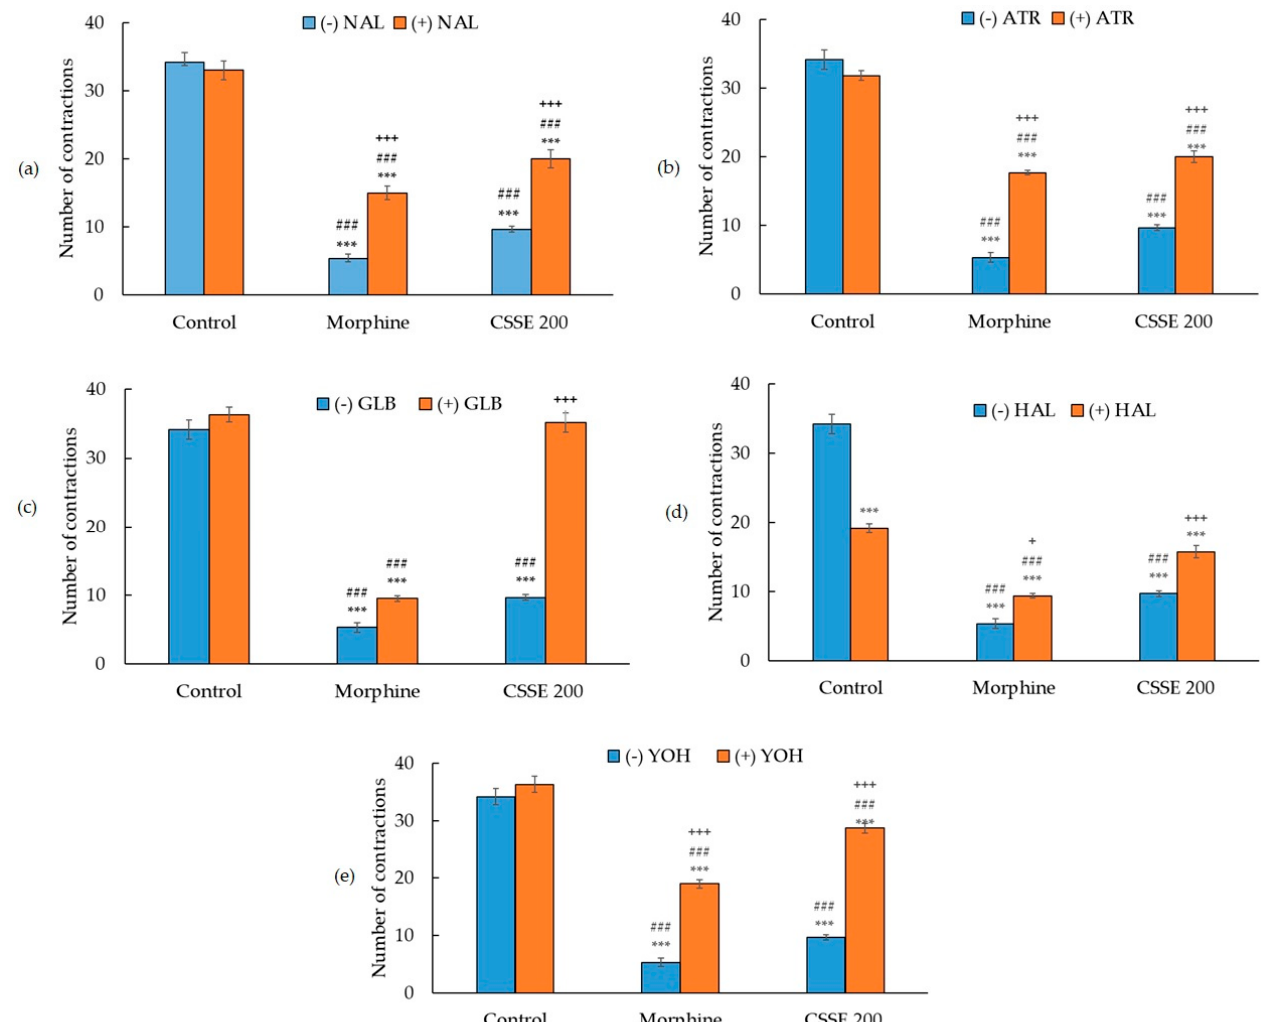
Figure 5. Effect of CSSE on the nociceptive response to abdominal contractions induced by injection of acetic acid in mice pretreated with or without naloxone ( a ), atropine ( b ), glibenclamide ( c ), haloperidol ( d ), and yohimbine ( e ); 15 min before administration of CSSE or morphine. Each value represents the mean ± SEM ( n = 6); Statistical significance was calculated by ANOVA I followed by Tukey’s test. *** p < 0.001 when comparing all groups to the control group; ### p < 0.001 when comparing all groups to the control group pretreated with naloxone ( a ), atropine ( b ), glibenclamide ( c ), haloperidol ( d ), and yohimbine ( e ); + p < 0.05, +++ p < 0.001 when comparing CSSE-treated group or morphine-treated group with the corresponding group pretreated with naloxone ( a ), atropine ( b ), glibenclamide ( c ), haloperidol ( d ), and yohimbine ( e ). In the hot plate model, naloxone lowered the pain threshold of CSSE-treated mice to equal that of the control group as for morphine (Figure